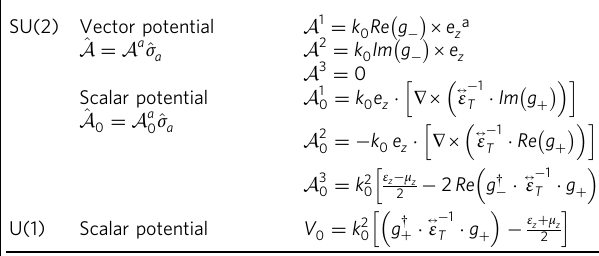
Table 1 The expressions of the synthetic SU(2) and U(1) gauge potentials in terms of the constitutive parameters of the non-Abelian